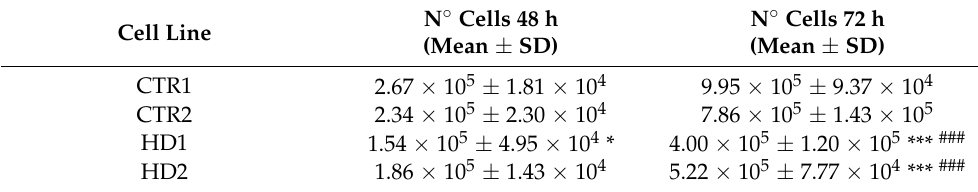
Table 4. Number of CTR1, CTR2, HD1 and HD2 fibroblasts at 48 and 72 h in basal conditions. Number of cells is shown as mean ± standard deviation (SD). * p < 0.05 and *** p < 0.0001, compared with CTR1 (Two-way ANOVA, followed by uncorrected Fisher’s LSD for multiple comparison); ### p < 0.0001, compared with CTR2 (Two-way ANOVA, followed by uncorrected Fisher’s LSD for multiple